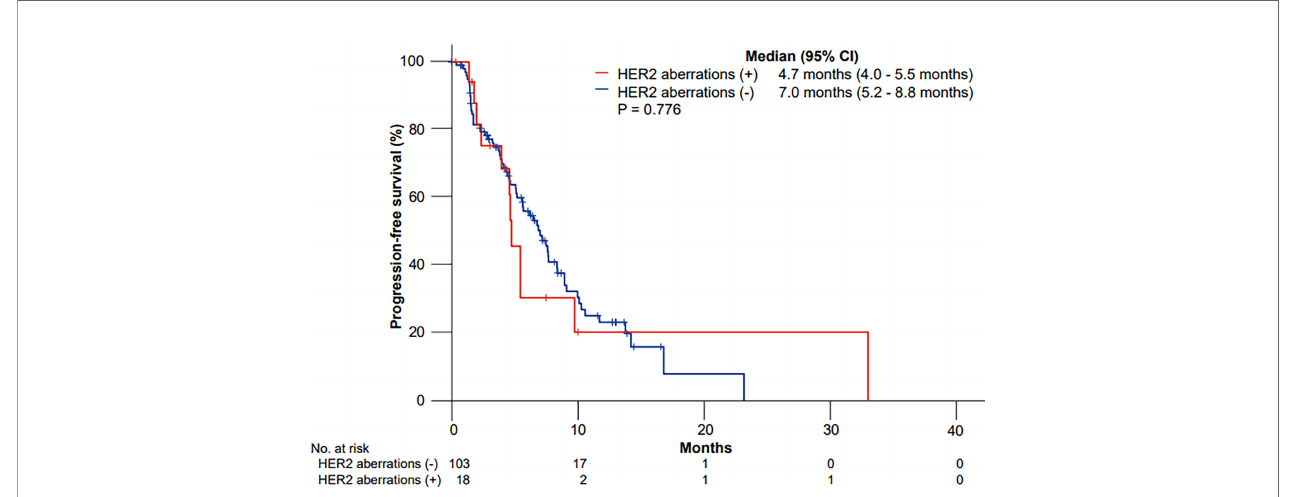
FIGURE 1 | Kaplan – Meier curves of progression-free survival (PFS) to gemcitabine plus cisplatin according to HER2